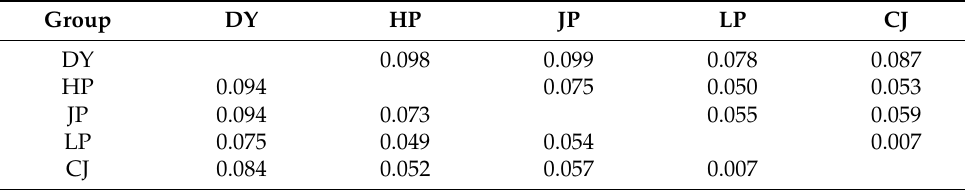
Table 2. Table of interpopulation genetic differentiation coefficients (F ST ) and genetic distance (DR).